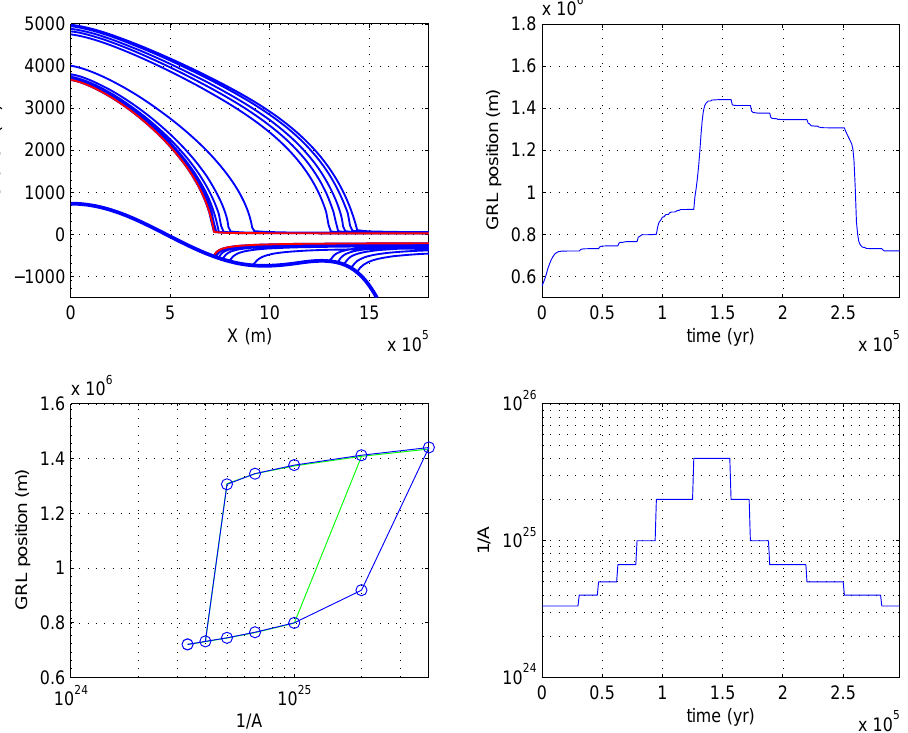
Fig. 2. Results of EXP 3 performed with a participating FGH model (Docquier et al., 2011) with 1x = 12 . 5km. The different panels show the steady state ice sheet profiles with the red profile, the final profile at the end of EXP 3, the position of the grounding line in time, steady state grounding line positions as a function of the forcing viscosity ( A − 1 ) and the forcing of A − 1 over time. The green line is the path according to the boundary layer theory (Schoof,